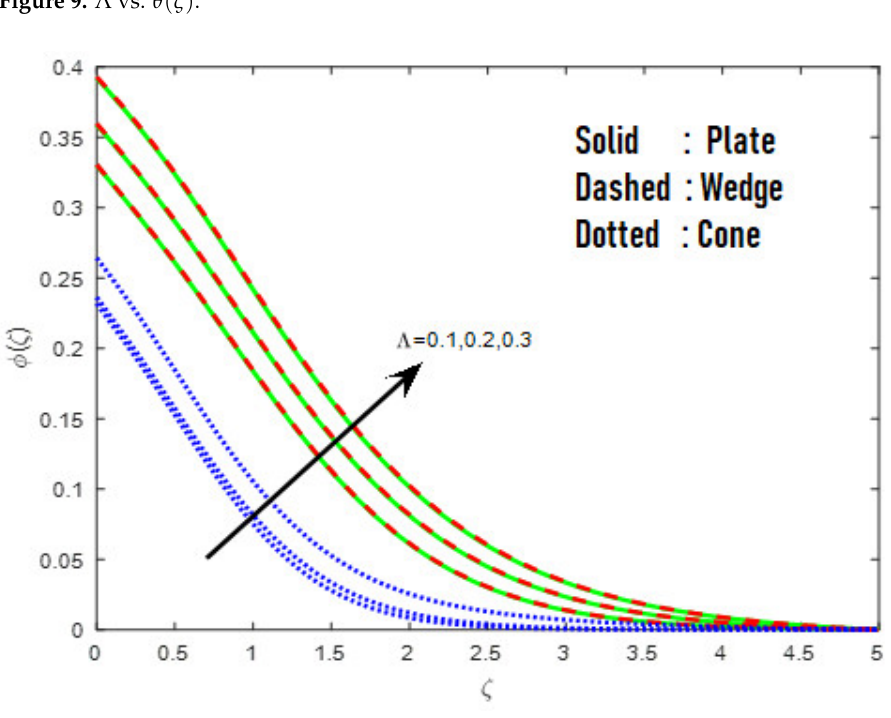
 vs.     . Figure 9. Λ vs. θ ( ζ ) . Figure 9. Figure 9.